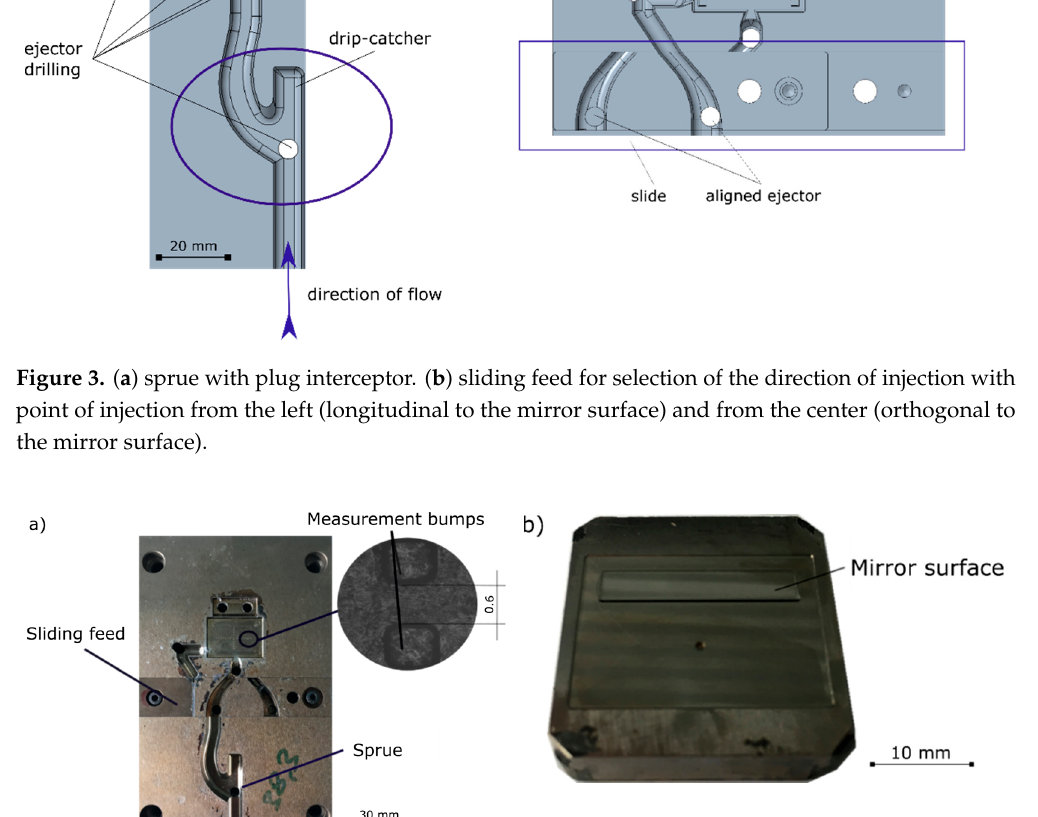
Figure 3. ( a ) sprue with plug interceptor. ( b ) sliding feed for selection of the direction of injection with point of injection from the left (longitudinal to the mirror surface) and from the center (orthogonal to the mirror surface).